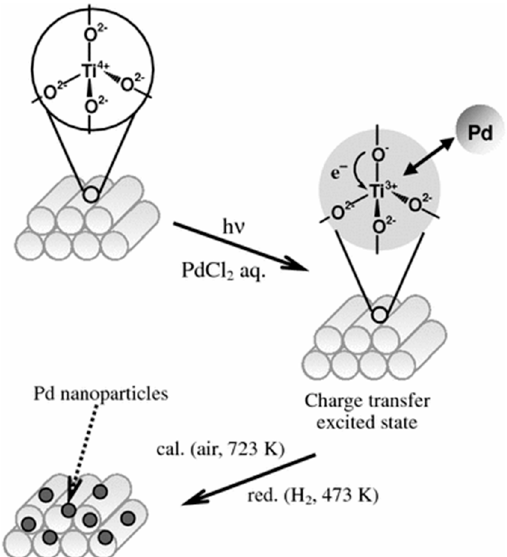
Figure 51. The formation of charge transfer excited state with tetrahe- drally coordinated Ti oxide moiety within Ti-MCM-41 by UV light irradiation and its application for the synthesis of nano-sized metal particles. Reproduced with permission from [113]. Copyright 2009 Springer.